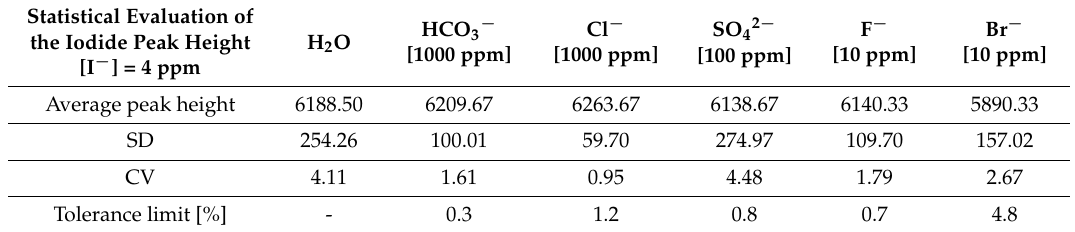
Table 6. The tolerance limits of the interfering ions in the height of the iodide peak.